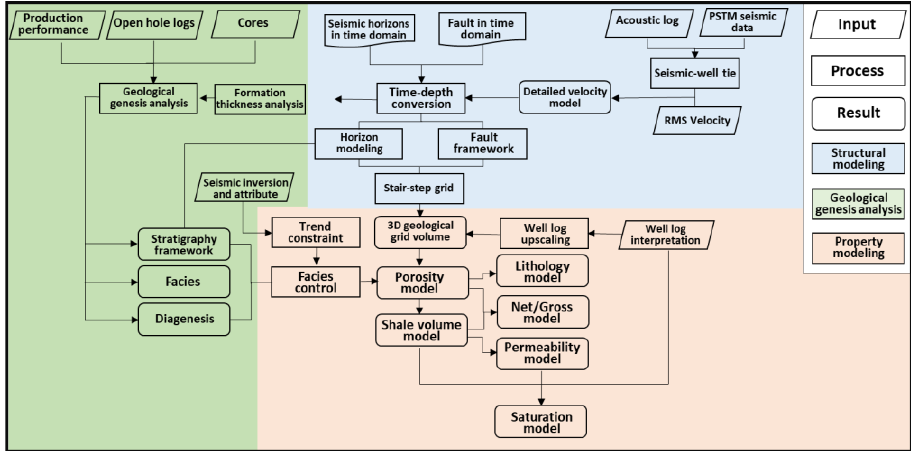
Figure 3. A general workflow of this study. The workflow includes two major parts: geological genesis analysis, and structural and property modeling. The structural and property modeling is guided by the geological genesis analysis.